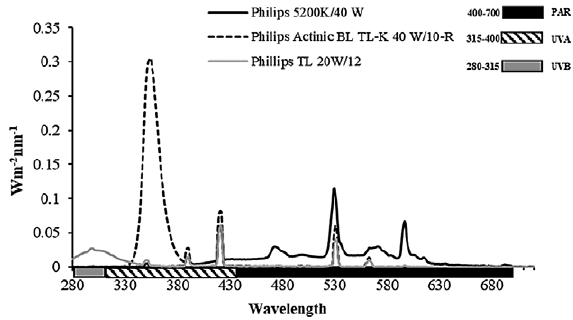
Fig. 1. – Total radiation spectrum emitted by radiation sources: PAR (400-700 nm), UVA (315-400 nm) and UVB (280-315